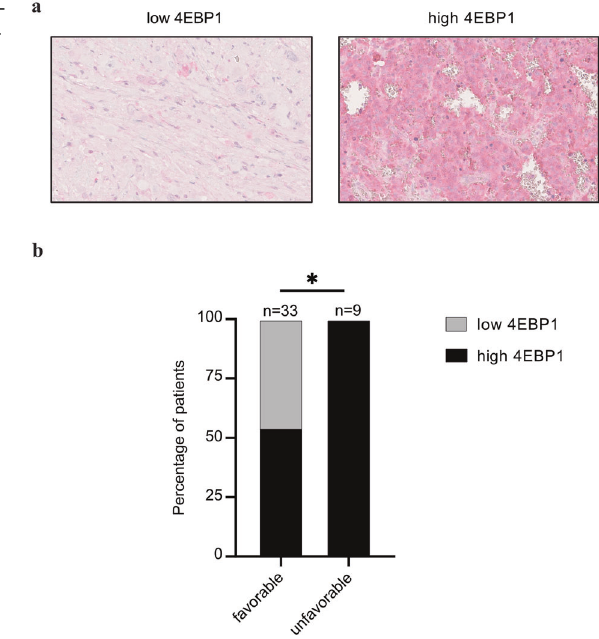
Fig. 3 4EBP1 protein expression is associated with histological subtype of NB. a Representative images at 40X magni fi cation of low (left panel) and high (right panel) 4EBP1 immunohistochemical staining levels of selected NB samples represented on the NB TMAs. b Distribution of NB cases showing low (IRS 0 – 6) versus high (IRS 7 – 12) 4EBP1 protein expression in prognostically favorable versus unfavorable histological subtypes according to International Neuro- blastoma Pathology Classi fi cation (INPC). Fisher ’ s exact test was used to calculate signi fi cance. * P <